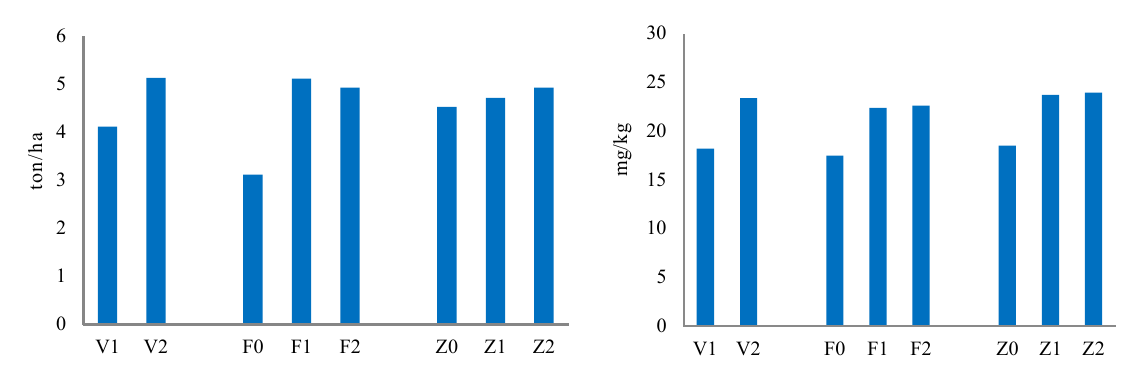
Fig. 5. Mean comparison of variety, Iron and Zinc simple effects on yield.